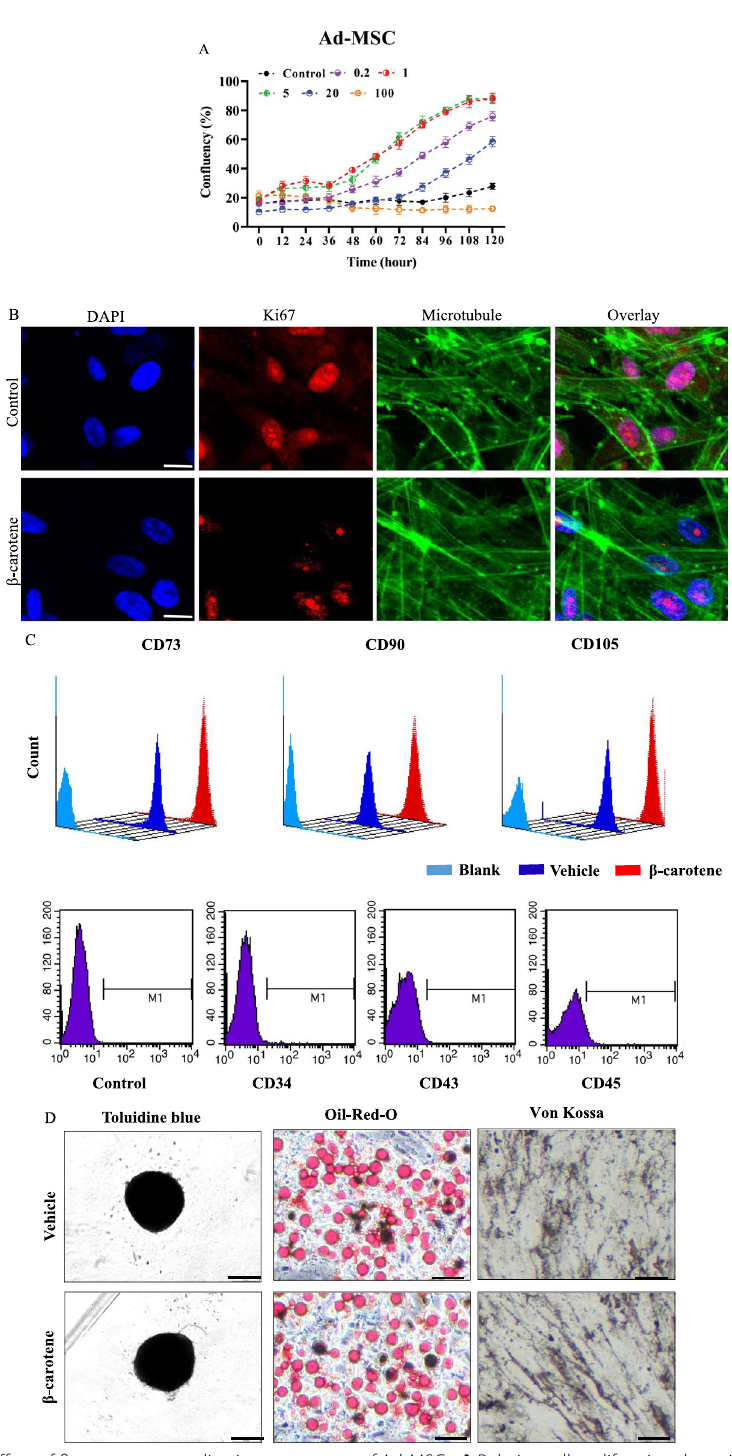
Fig. 5 Effect of β-carotene on replicative senescence of Ad-MSCs. A Relative cell proliferation detection upon β-carotene treatment by using the IncuCyte S3 live-cell imaging system. n percentage of Ki67-positive cells was increased by β-carotene treatment. At least 50 cells were statistically analyzed. C , D Effect of β-carotene on the properties of